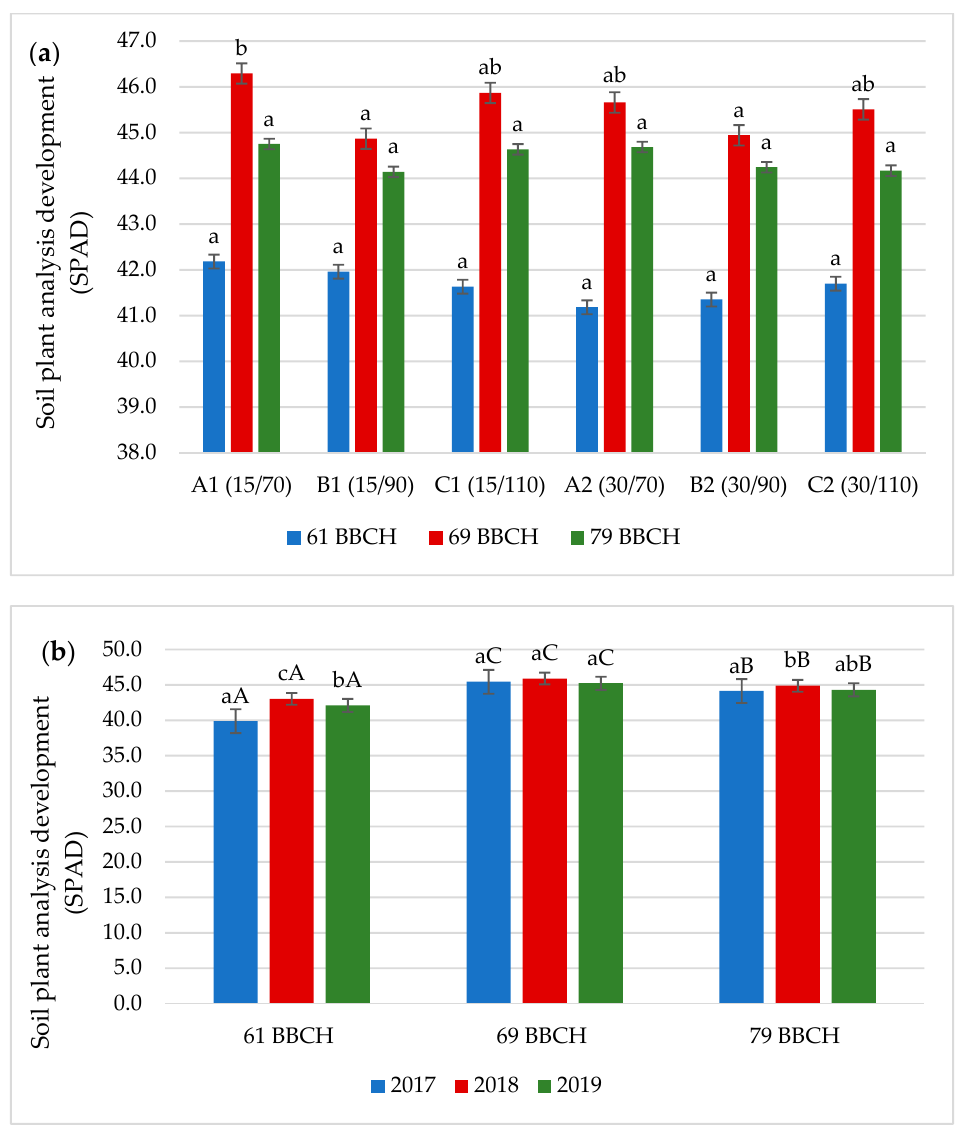
Figure 2. Effect of row spacing and sowing density on soil plant analysis development (SPAD) of soybean ( a ) between variants of the experiment during the 3-years study ( b ) between years of research. Lowercase letters indicate significant differences between the means in the measurement phases, capital letters indicate significant differences between means in the years of research according to ANOVA (followed by Tukey’s HSD test, p = 0.05).